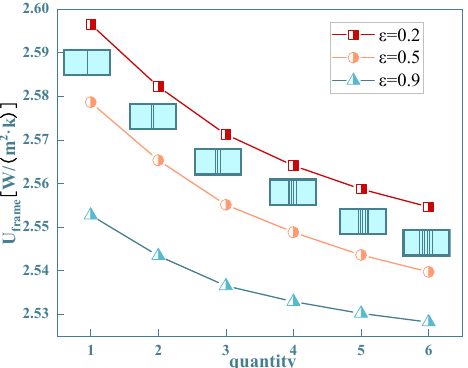
Figure 10. Effect of the number of RIP on the U-factor of the window frame.